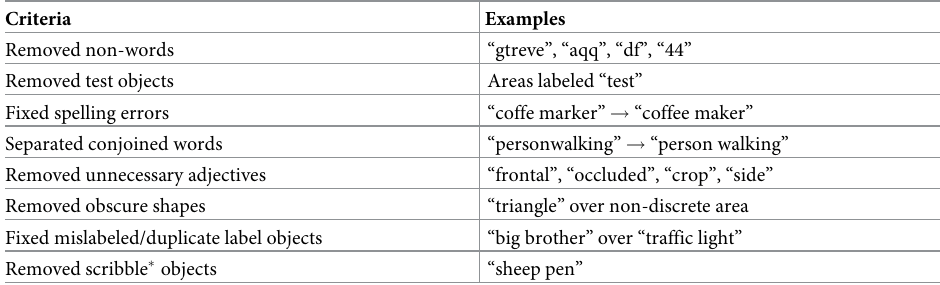
Table 1. List of criteria for manually editing object